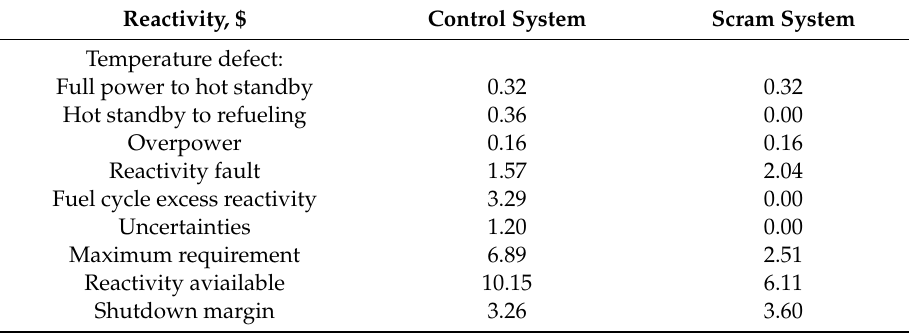
Table 6. Reactivity worth of control and scram systems at BOC.